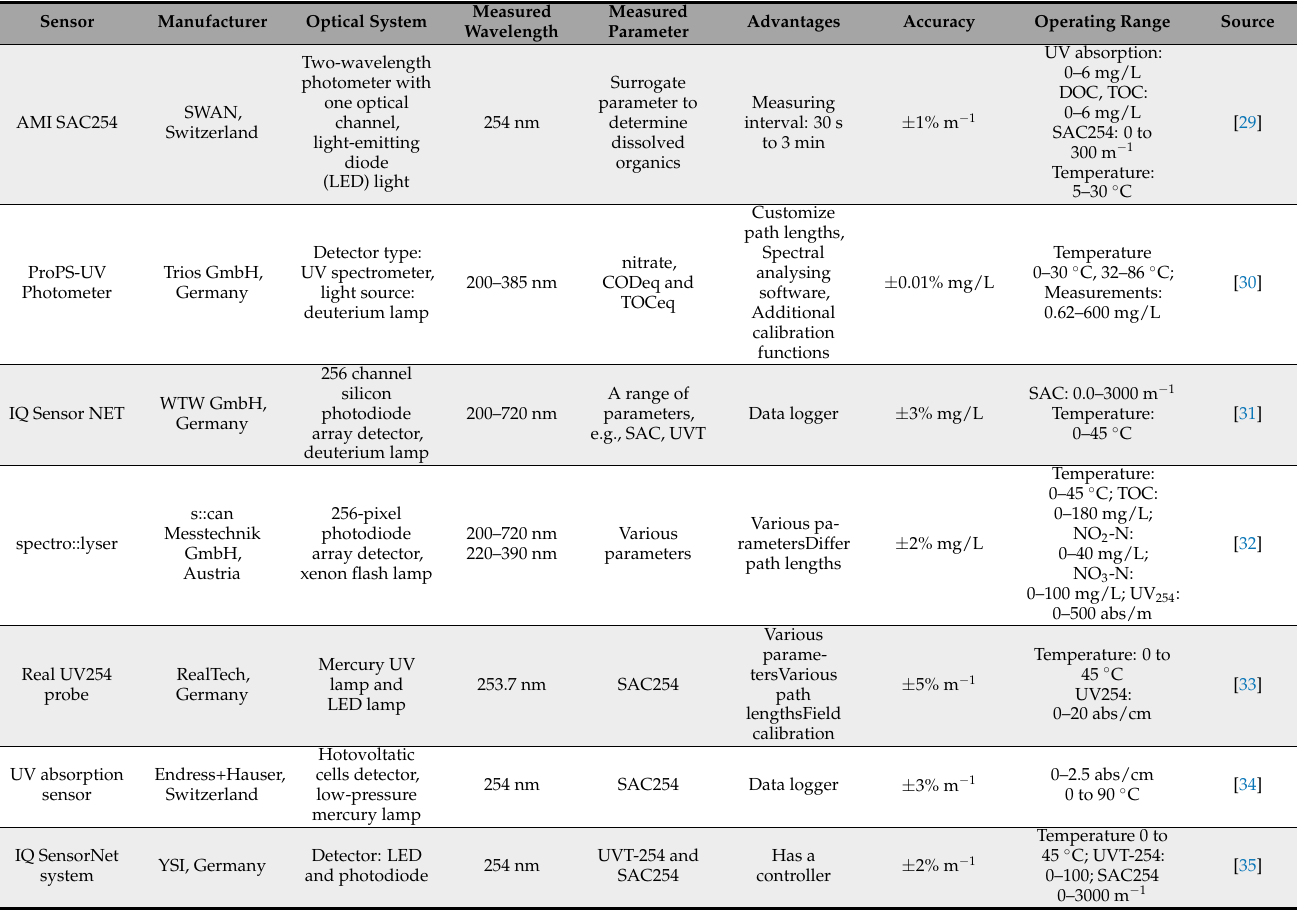
Table 1. Summary of common online UV-Vis instruments for water quality monitoring and process